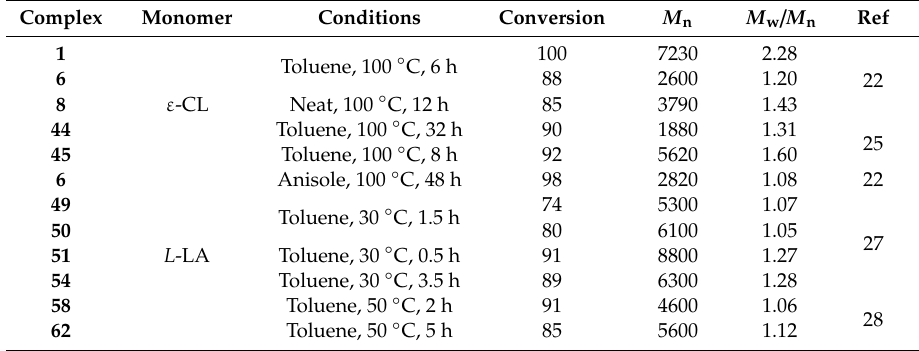
Table 25. Comparison between titanium diphenolate catalysts in the ROP of ε -CL and L -LA. Complex Monomer